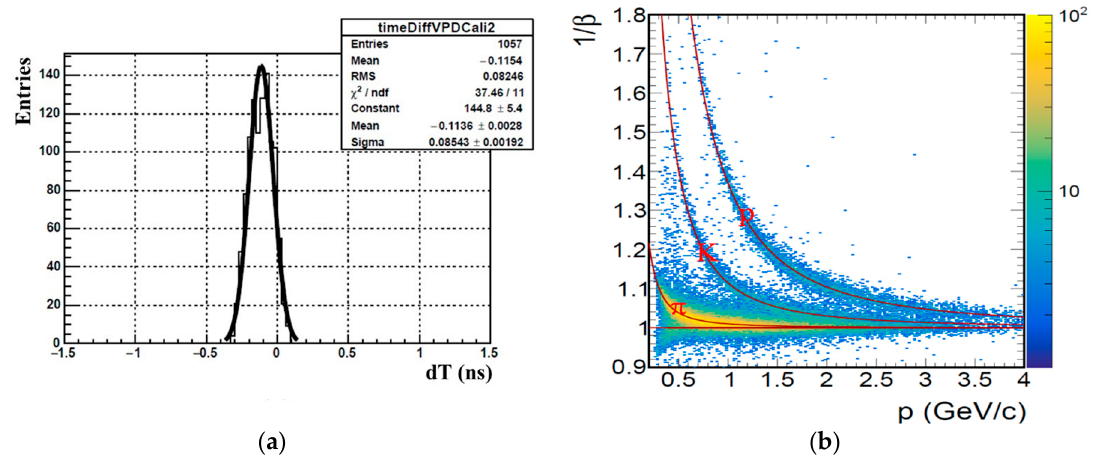
Figure 9. ( a ) System time resolution obtained with relativistic pions. The distribution is fitted by a gaussian function, as shown in the black line. ( b ) 1/ β versus particle momentum.